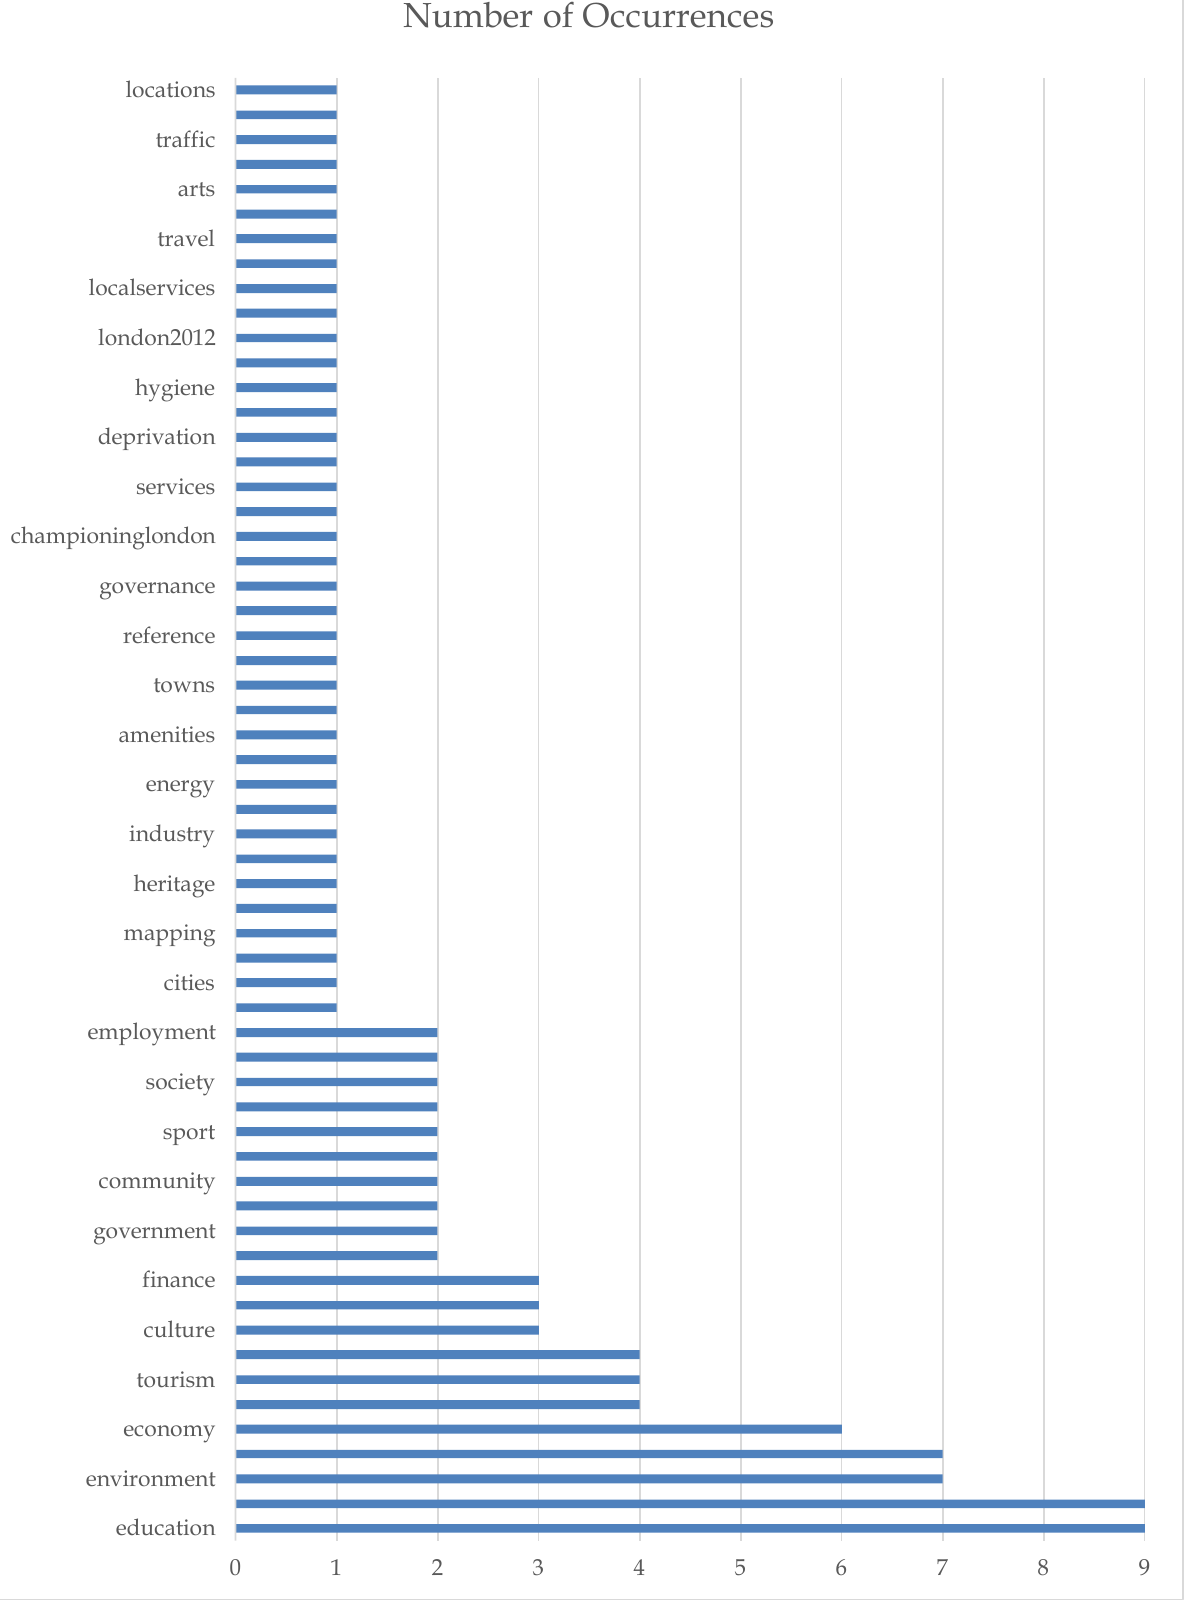
Figure 4: Categories of the UK's Open Data Catalogs as well as their